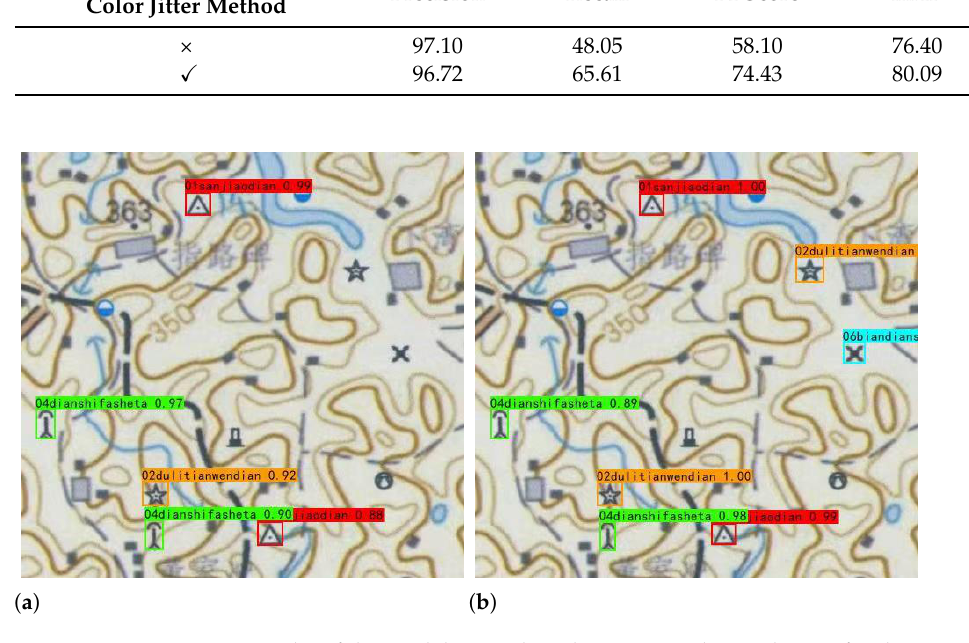
Figure 23. Recognition results of the model trained on the vectorized map dataset for the scanned Map H. ( a ) Recognition results without the Gaussian blur and color jitter data augmentation method. ( b ) Recognition results with the Gaussian blur and color jitter data augmentation